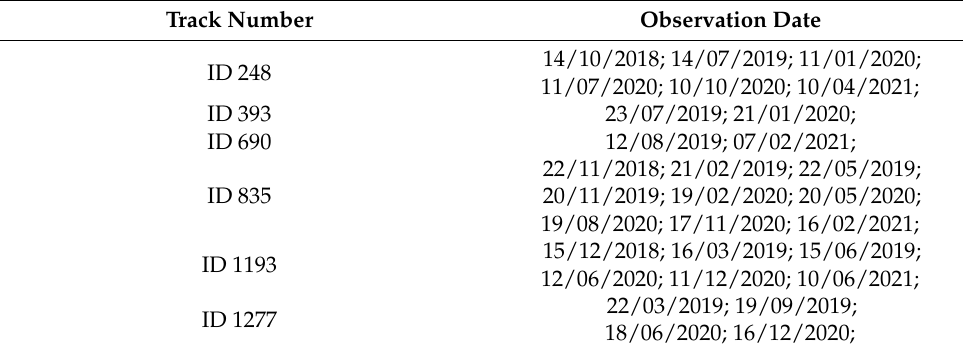
Figure 3. Distribution of ICESat-2 data across Ngoring Lake. Table 1. Summary of ICESat-2/ATL13 Data across Ngoring